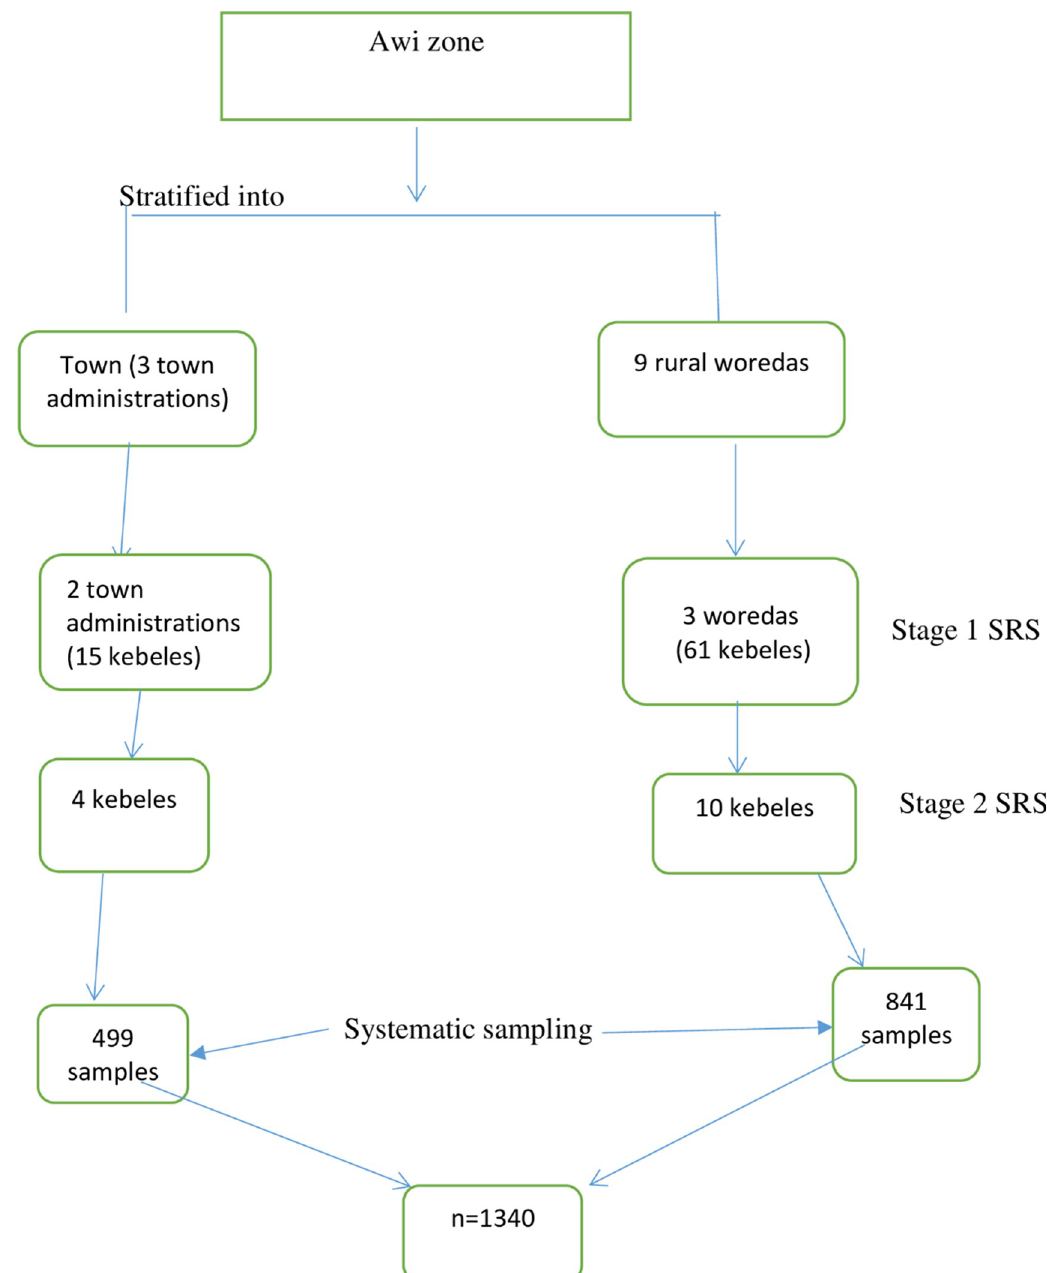
Fig 1. Sampling procedures and